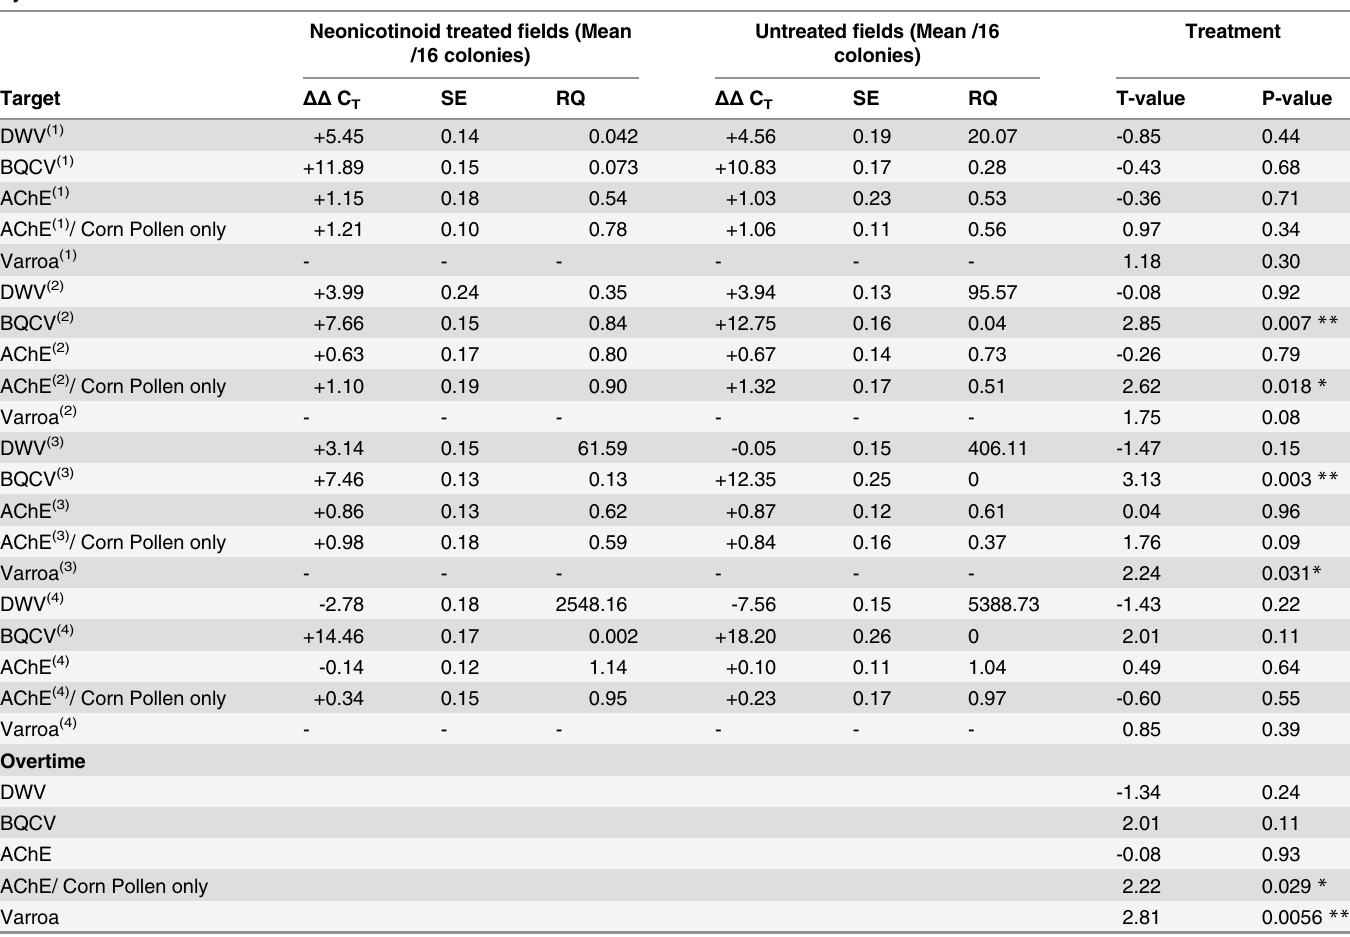
Table 2. Contrasts in honeybee pathogen abundance (deformed wing virus DWV, black queen cell virus BQCV and varroa) and AChE expression by date and neonicotinoid treatment. Neonicotinoid treated fi elds (Mean Untreated fi elds (Mean /16 /16 colonies) colonies)